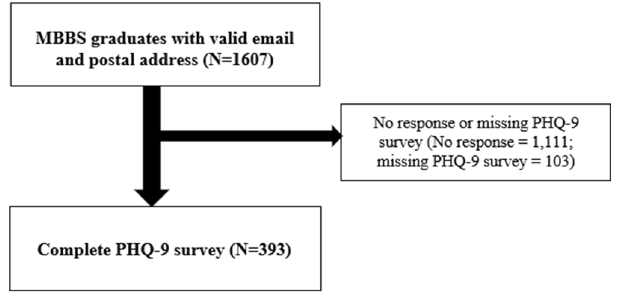
Figure 1. Flow chart showing the sampling and response rates. MBBS, Bachelor of Medicine and Bachelor of Surgery; PHQ-9, Patient Health